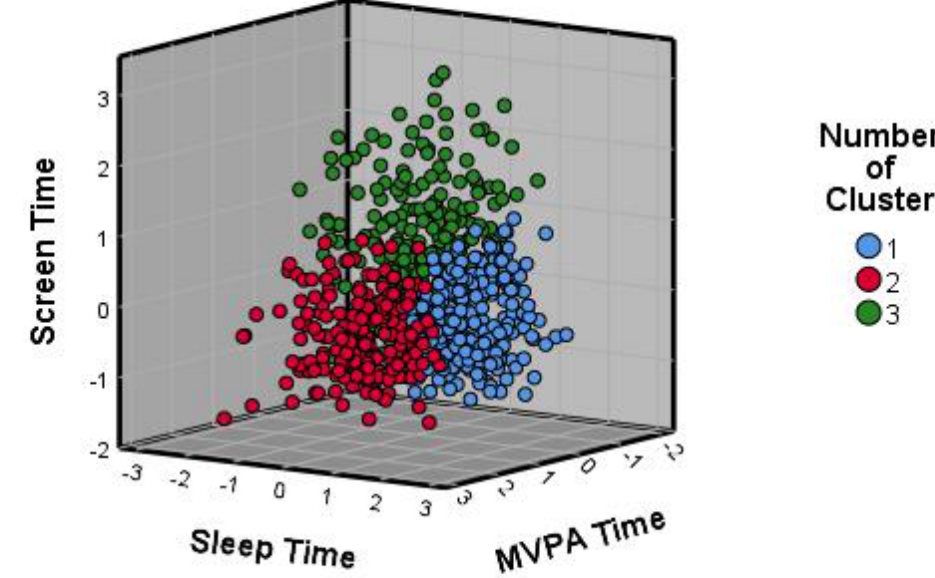
Figure 1. The scatter plot of participants’ z-scores. Note. Moderate–vigorous Physical Activ- ity